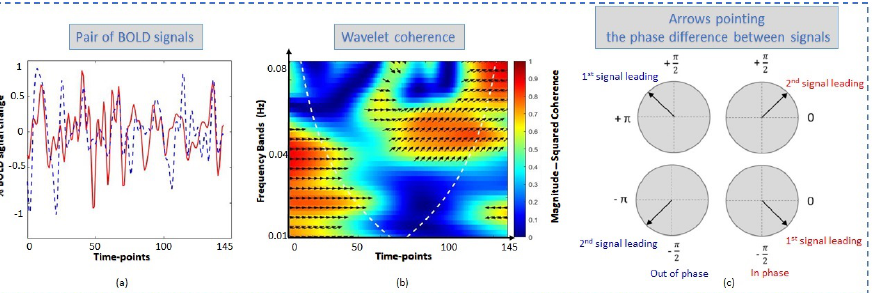
Figure 2. Wavelet coherence formation of ( a ) a pair of BOLD signals, ( b ) its corresponding wavelet coherence and ( c ) arrows showing the phase difference between the two signals x ( t ) and y ( t ) . The vertical and horizontal axes in ( b ) show the frequency and recording time of the BOLD signals, respectively. In ( b ), the darker red regions represent a higher degree of coherency, and the white overlay defines the cone of influence. In ( c ), the arrows are indications of the phase coherence, which is the ratio of leading to lagging